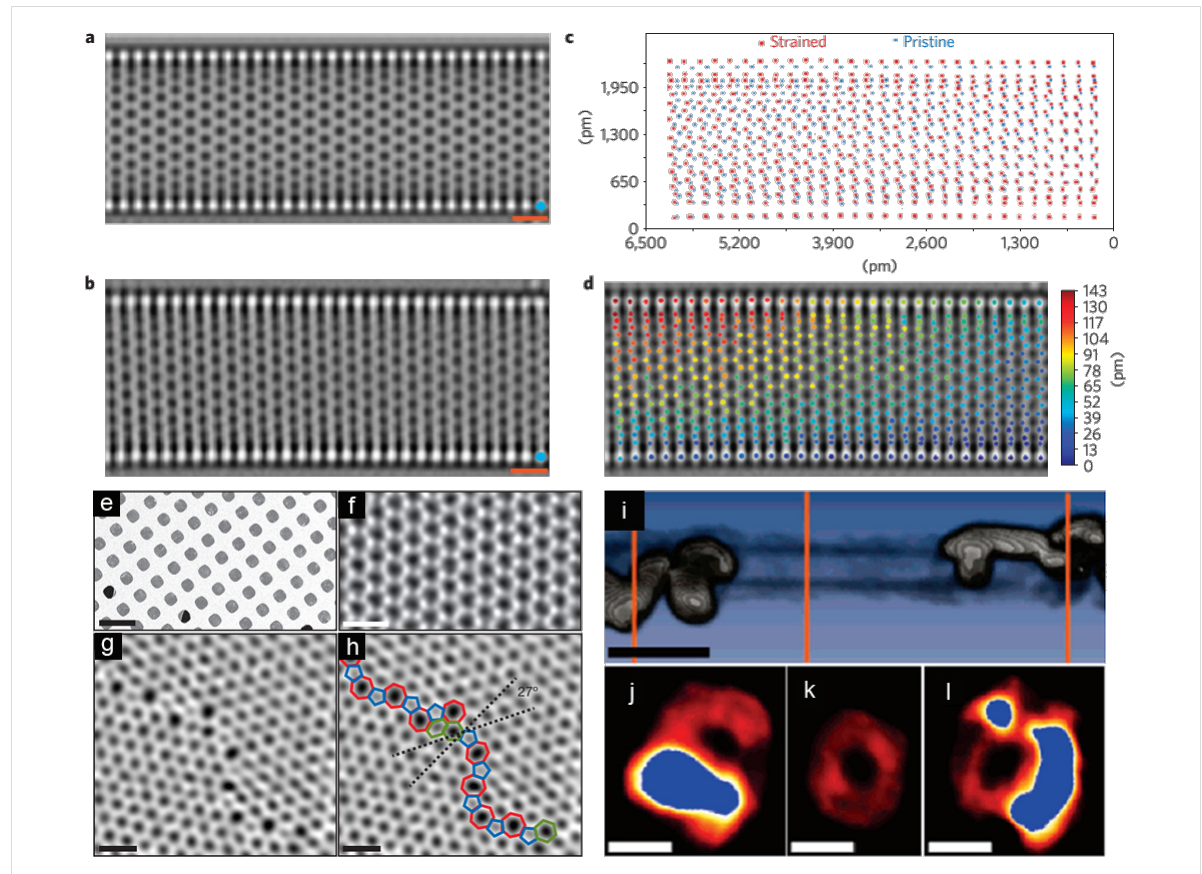
Figure 5: (a–d) Obtaining a 2D displacement map of a (28,0) SWCNT; reproduced with permission from [60], Copyright (2011) Nature Publishing Group. (a) HRTEM image simulation of a (28,0) SWCNT. Scale bar: 500 pm. (b) Experimental AC-TEM image of a (28,0) SWCNT with strain. Scale bar: 500 pm. (c) Overlay of atomic column positions measured from a (28,0) SWCNT in simulated (a) (blue) and experimental (b) (red) HRTEM images. (d) 2D displacement map, overlaid on top of the HRTEM form (b). (e–h) ADF-STEM images of graphene crystals; reproduced from [62], Copyright (2011) Nature Publishing Group. (e) Scanning electron micrograph of graphene transferred onto a TEM grid. (f) ADF-STEM image showing the defect-free hexagonal lattice inside a graphene grain. (g) Two grains intersect with a relative rotation of 27°. An aperiodic line of defects stitches the two grains together. (h) The image from (g) with the pentagons (blue), heptagons (red) and distorted hexagons (green) of the grain boundary outlined. Panels f–h were low-pass-filtered to remove noise; scale bars: 5 Å. (i–l) 3D reconstruction of a CNT in contact with Pd islands; reproduced with permissionfrom [83], Copyright (2007) American Chemical Society. (i) Volume rendering of the geometrically reconstructed CNT (black) with iso- intensity surface of Pd islands (white). Scale bar: 10 nm. (j-l) Cross-section views of the orange slices in (i). Scale bars: 4